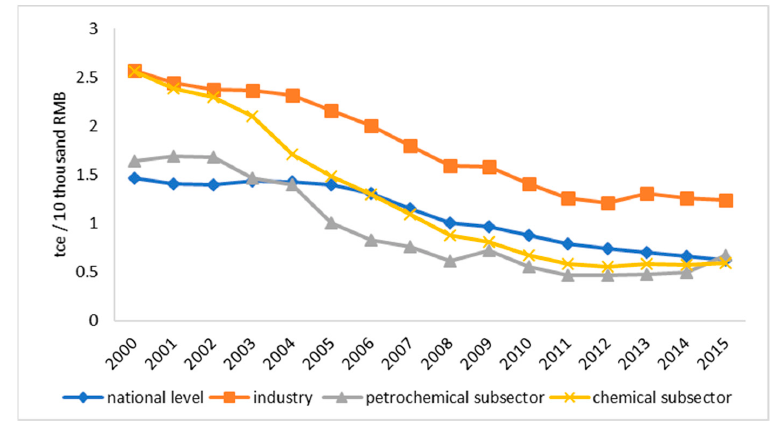
Figure 3. Energy intensity. Energy intensity of petrochemical and chemical industry has been decreasing with the decrease of the whole industry, and the rate of decent has become stable since